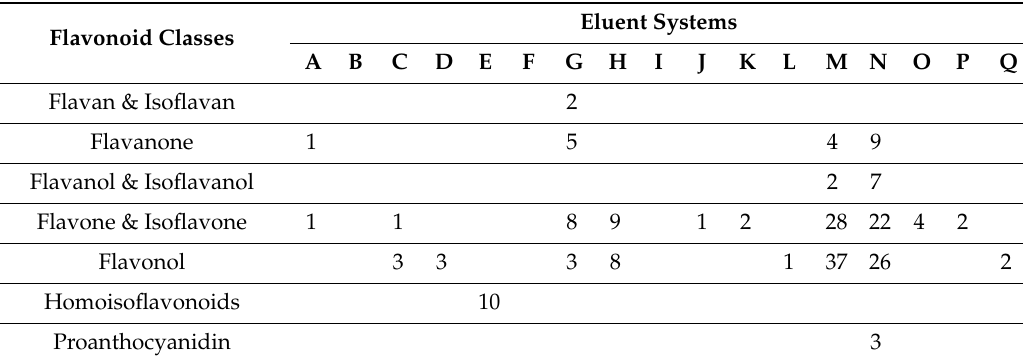
Table 1. Abundant of flavonoids isolated / purified by using di ff erent eluents on Sephadex ® LH-20. Eluent Systems Flavonoid Classes A B C D E F G H I J K L M N O P Q Flavan & Isoflavan 2 Flavanone 1 5 4 9 Flavanol & Isoflavanol 2 7 Flavone & Isoflavone 1 1 8 9 1 2 28 22 4 2 Flavonol 3 3 3 8 1 37 26 2 Homoisoflavonoids 10 Proanthocyanidin